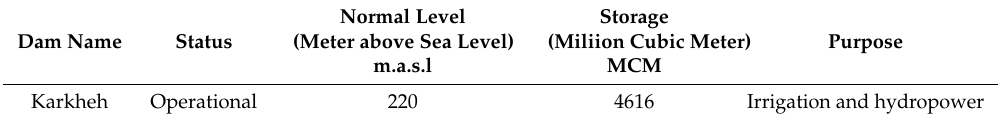
Table 1. Characteristics of Karkheh dam in Karkheh River Basin.